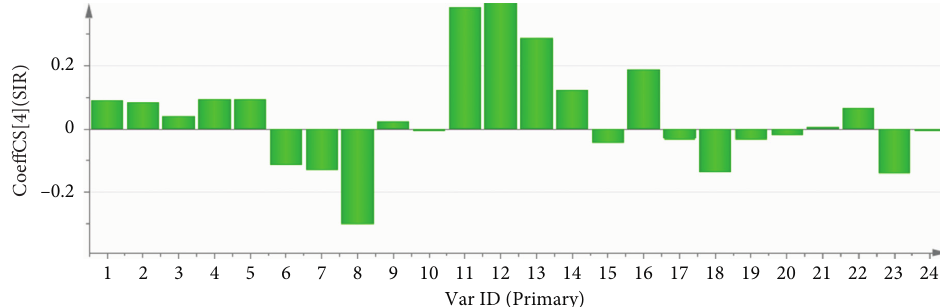
Figure 3: Coefficient of correlation of 24 chromatographic peaks with anti-inflammatory activity.